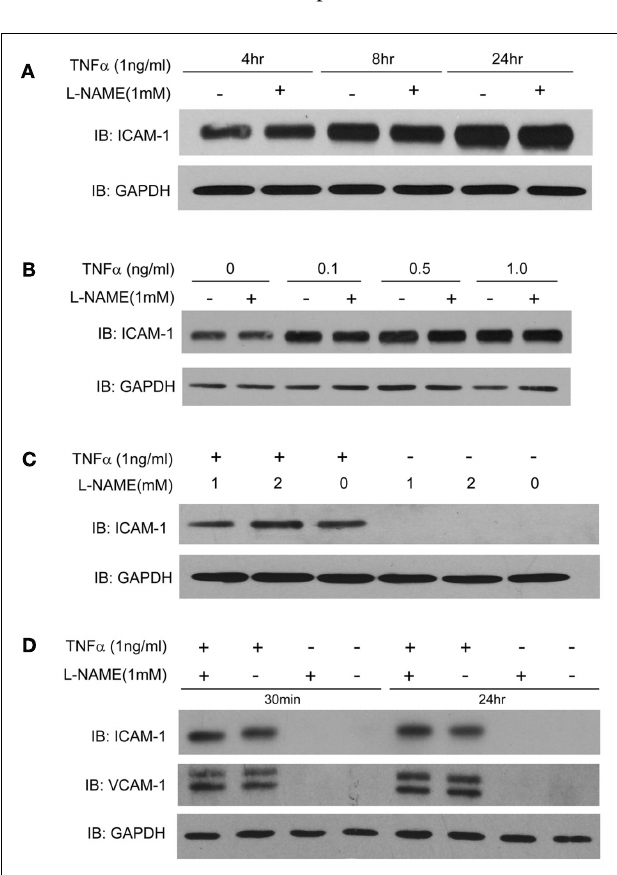
FIGURE 1 | (A) Human aortic endothelial cells were incubated withTNF α (1ng/ml) for 4, 8, and 24h, in the presence and absence of L-NAME (1mM, 30min pre-treatment). Cell lysates were immunoblotted using an anti-ICAM-1 antibody and GAPDH was used as a loading control. (B) HAECs were pre-treated with L-NAME for 30min, and stimulated with different concentrations ofTNF α (0.5, 0.1, 1ng/ml) for 24h. (C) HAECs were treated with different concentrations of L-NAME (1 or 2mM) for 30min, and then exposed toTNF α (1ng/ml) for another 24h. (D) HAECs were pre-treated with L-NAME (1mM) for different times (30min or 24h) prior to exposure toTNF α (1ng/ml) for an additional 24h. Cell lysates were immunoblotted using an anti-ICAM-1 or anti-VCAM-1 antibody and GAPDH was used as a loading control.